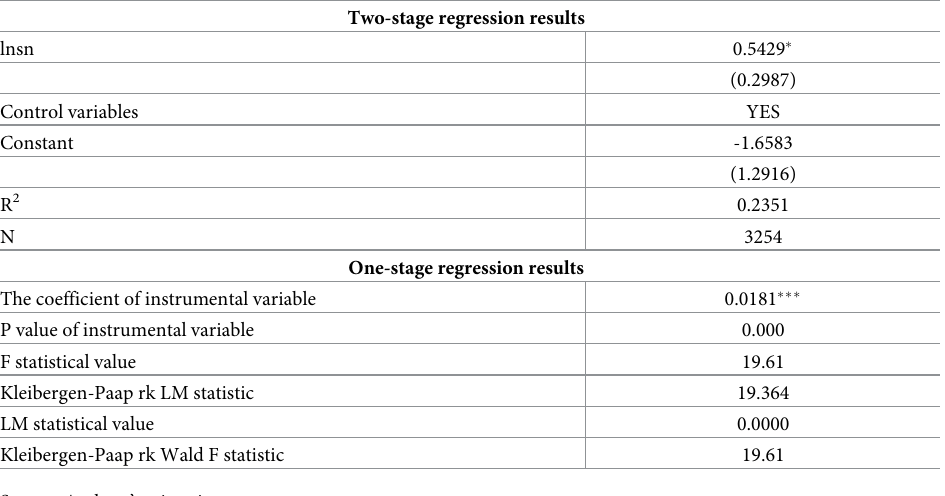
Table 3. Instrumental variable regression